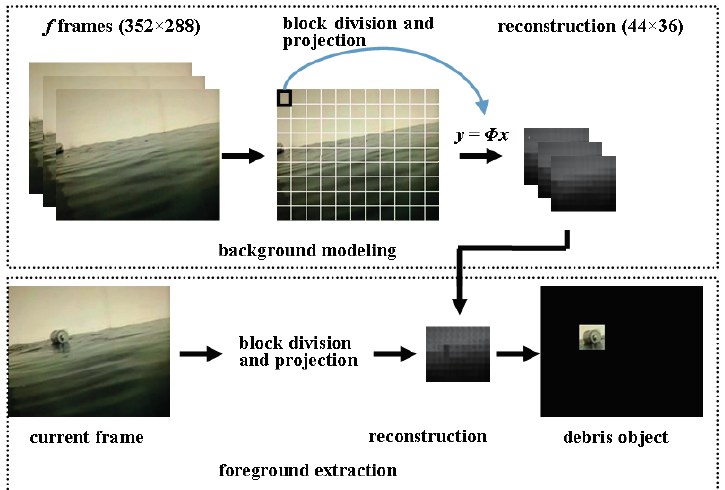
Figure 5. Compressive detection of aquatic